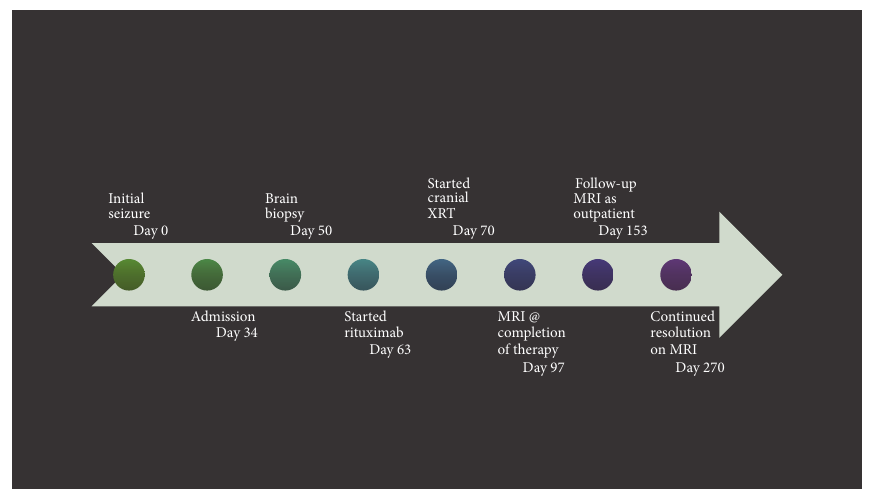
Figure 1: Timeline of events.